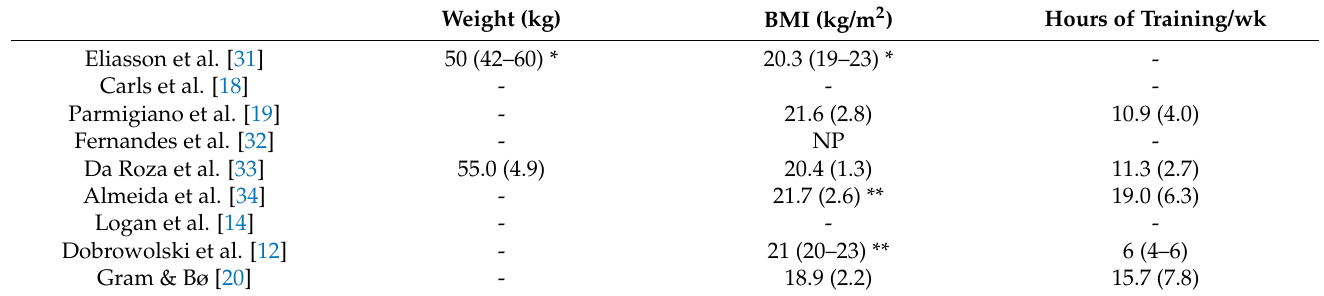
Table 2. Summary of participants’